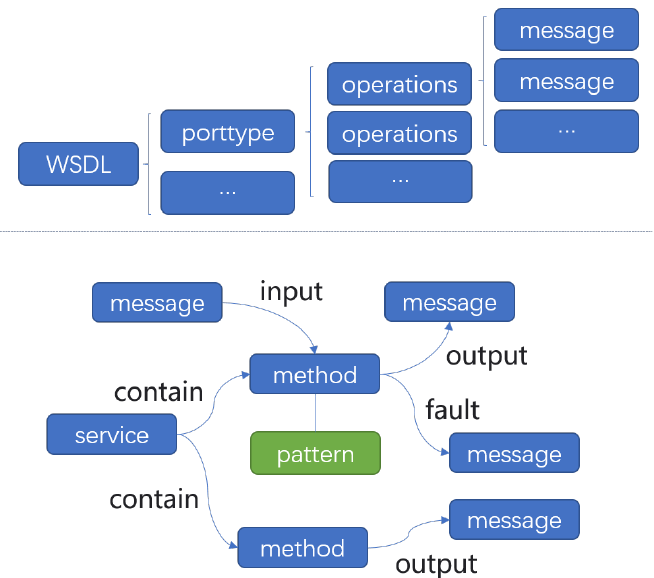
Figure 2. The porttype and operation elements expressed in WSDL are located at the top. The method and relationship defined between method and other ontology in service knowledge graph are shown below. The green box indicates that the content is an attribute, and the blue indicates element (in WSDL) or ontology (in service knowledge graph).